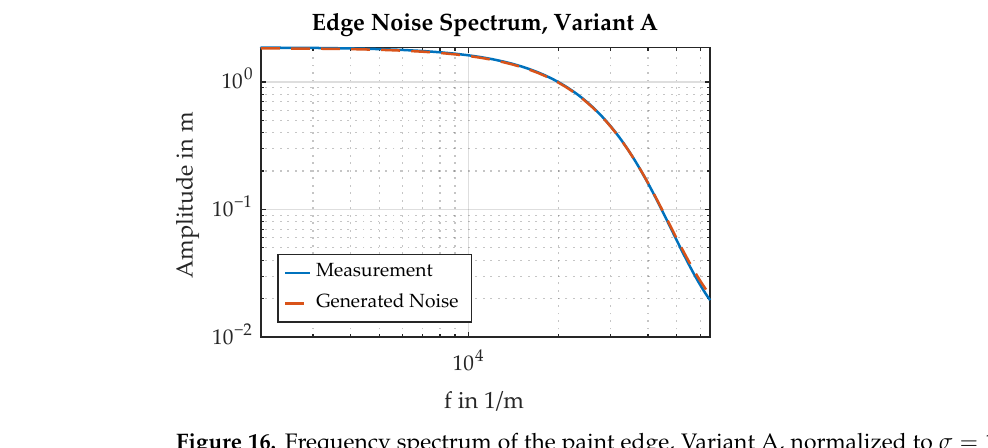
Figure 16. Frequency spectrum of the paint edge, Variant A, normalized to σ = 1. The generated noise has a similar spectrum to the measured edge noise.